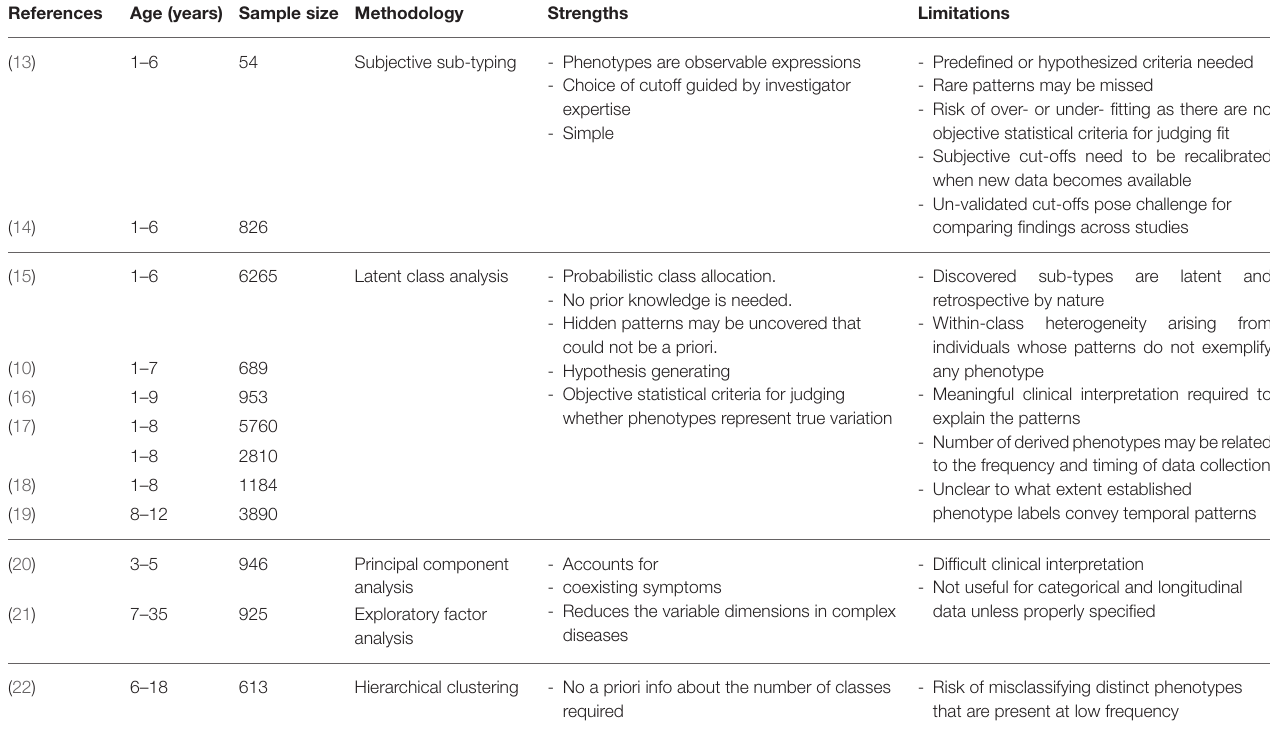
TABLE 1 | Different approaches for phenotypic discovery with the associated advantages and